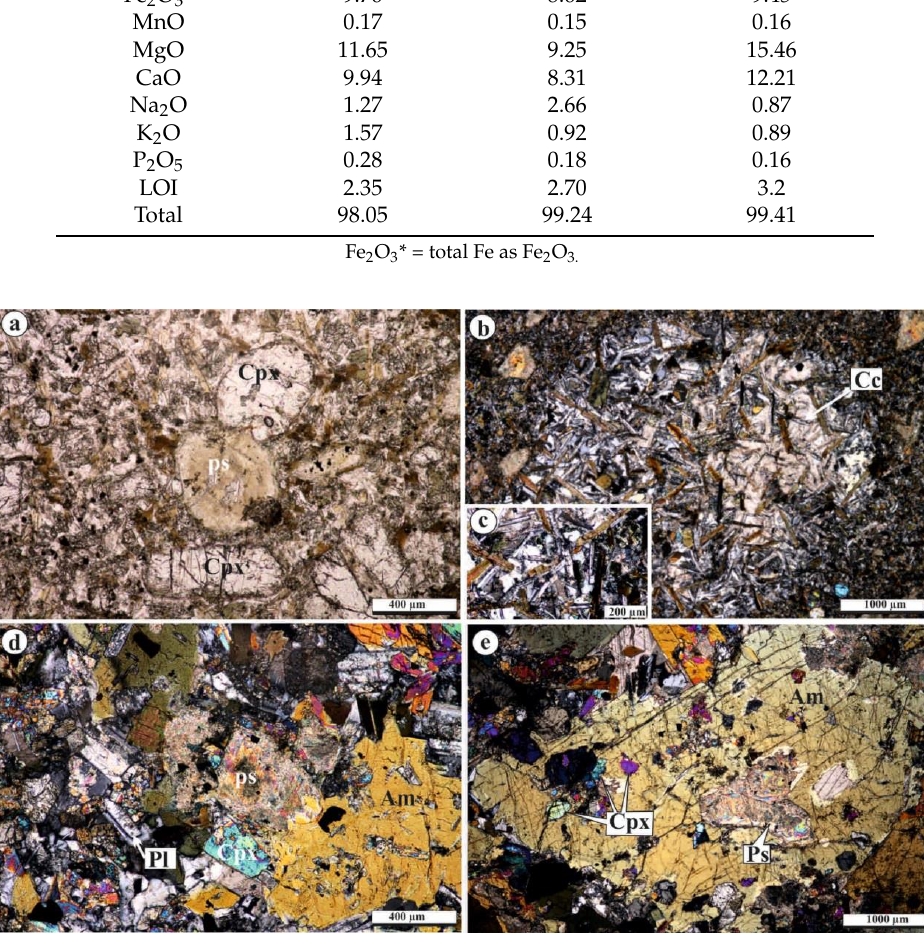
Figure 2. Photomicrographs of zoned lamprophyre dyke from Dobříš. ( a – c ) show minerals and textures of kersantite at the contact zone with the host siltstone. Note that the fine-grained matrix ( a ) contains phenocrysts of clinopyroxene (Cpx) and pseudomorphs of talc (ps) after olivine. ( b ) indicates ocellus filled by plagioclase, biotite, amphibole, and calcite (Cc). ( c ) is a detail of randomly oriented tabular grains of plagioclase, biotite, and amphibole. ( d ) Relatively coarse-grained matrix (about 80 cm from the contact zone) with large amphiboles containing or overgrowing clinopyroxene and pseudomorphs of talc. Note the zoning of plagioclase (Pl) in the matrix. ( e ) is from the central part of the dyke with large poikiloblasts of amphiboles with inclusions of clinopyroxene, plagioclase, and talc pseudomorphs. Farther from the dyke rim, the rock gradually becomes coarse-grained. Although the matrix Table 1. Bulk rock composition of different rock varieties in the dyke. phases can have a size of up 0.4 mm, the coarsening is mainly due to amphibole grains (up to 1.5 mm in size) that overgrow or enclose clinopyroxene and pseudomorphs after olivine (Figure 2d). It has a brown color that transitions to green rims. In contrast to the contact zone, biotite content decreases (<1 vol%), and that of amphibole increases (up 60 vol%). The amounts of clinopyroxene phenocrysts and talc pseudomorphs also decrease due to their replacement by amphibole. Matrix minerals